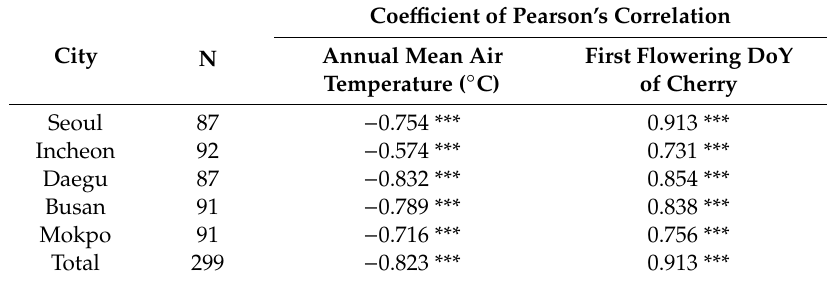
Table 3. The relationship between green-up DoY AGDD of Mongolian oak and the annual mean air temperature and the first flowering DoY of cherry.